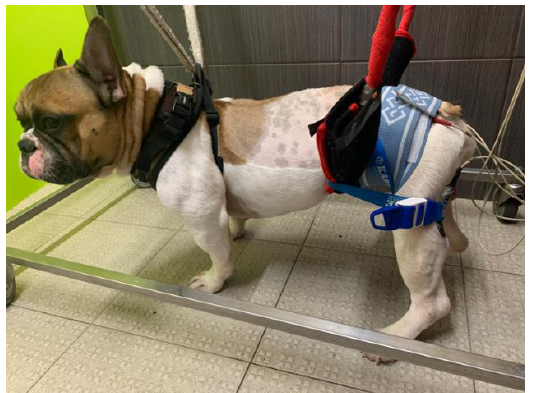
Figure 1. Functional electrical stimulation. One electrode was placed at L7-S1 region and one close